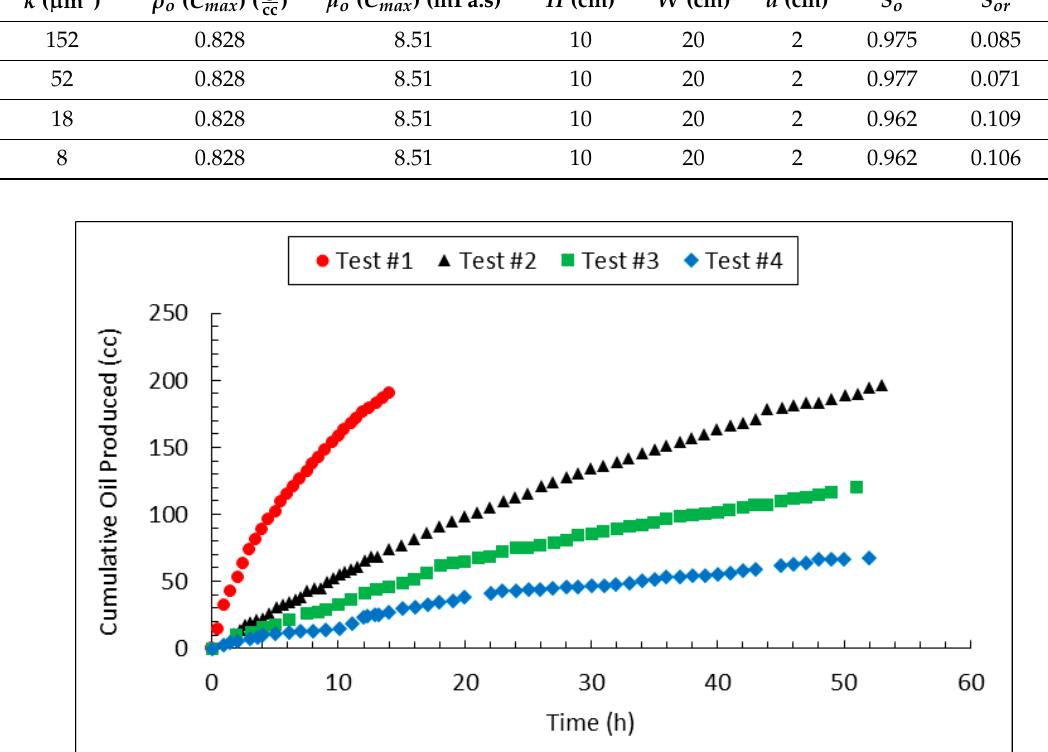
Figure 9. Actual cumulative production data for the experimental cases presented by Ma et al. [3].